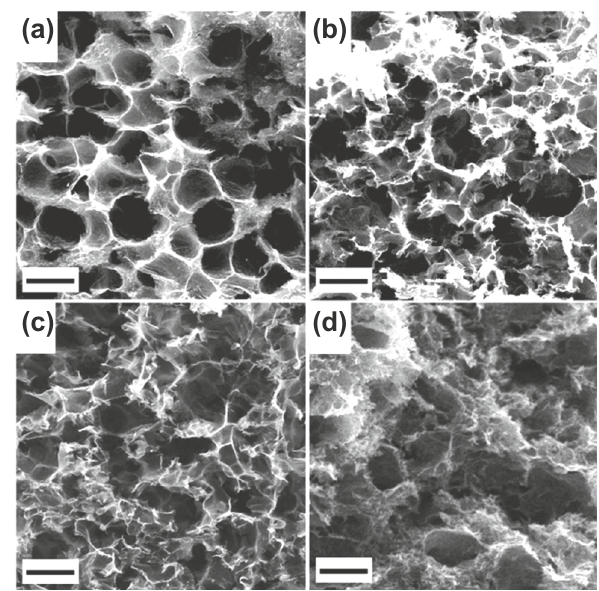
Fig. 3 a-d SEM micrographs of graphene aerogels at different reduc- tion temperatures: non-treated ( a ), 400 ( b ), 600 ( c ) and 1000 °C ( d ) under Ar/H 2 1:0.15 atm. The scale bar denotes 200 μm [97]; Copy- right © 2019 Elsevier